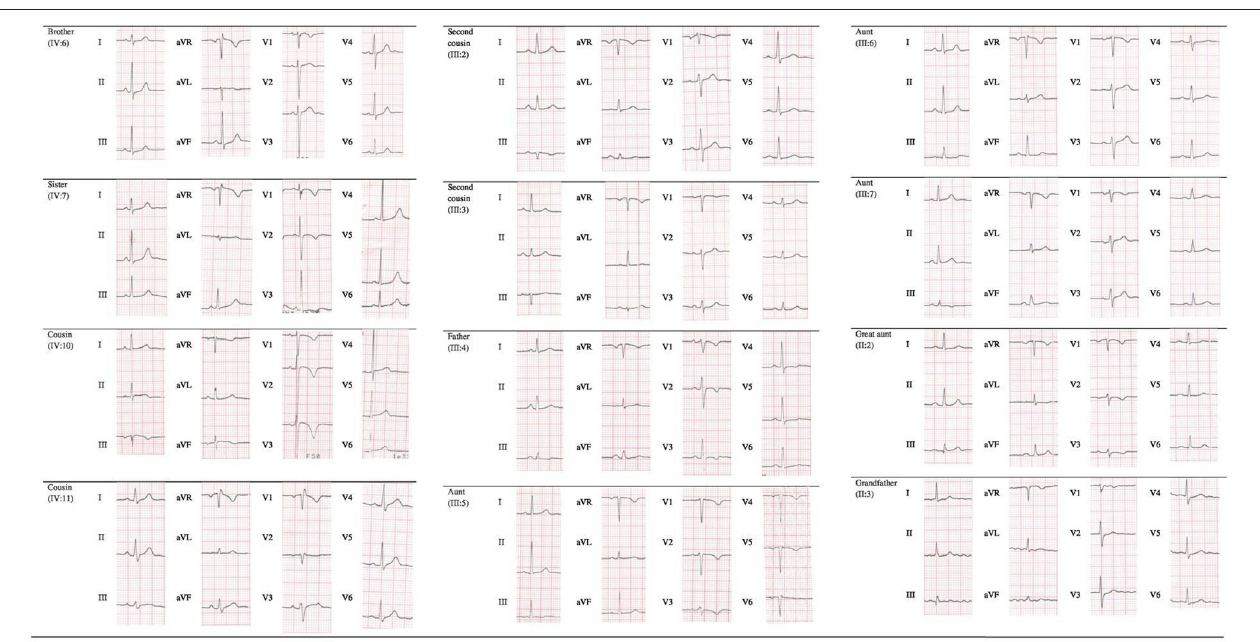
FIGURE 2 | Electrocardiogram (ECG) finding in gene carriers.